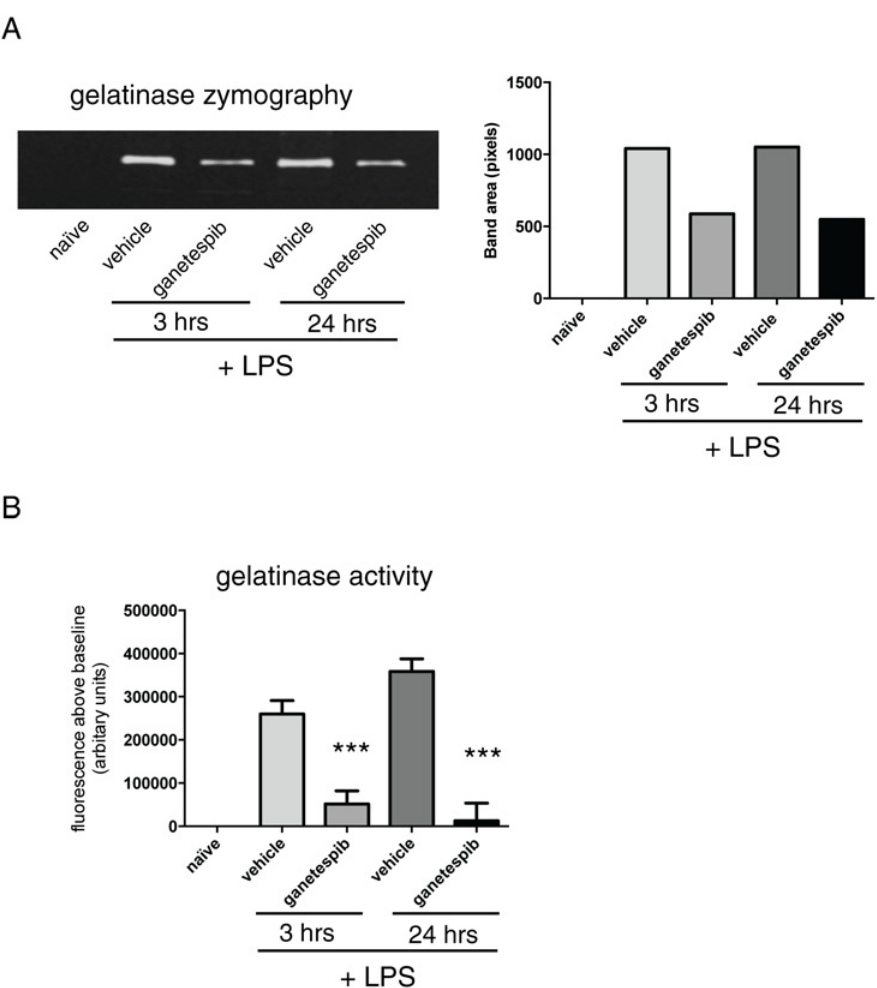
Figure 3. Ganetespib inhibits net gelatinase and MMP-9 gelatinase activity in BALF. Balb/c mice were treated with Ganetespib (50 mg/kg, i.v. or vehicle) and challenged with LPS (10 µ g/mouse, tn). (A) 102 – 105 kDa (size markers not shown) MMP9 gelatinase activity of pooled BALF samples determined by gelatin zymography. Left panel, original lucent bands revealed on post-stained gel; right panel corresponding band densitometry in arbitrary units (image pixels). Pooled samples, no statistics. (B) Net gelatinase activity in unfractionated whole BALF collected 3 and 24 h post LPS was determined in individual mice by fluorogenic substrate assay. Data are mean ± SEM. n = 8 mice per group. (na ï ve; n = 4). *** p < 0.001 compared to LPS/ vehicle treated mice.